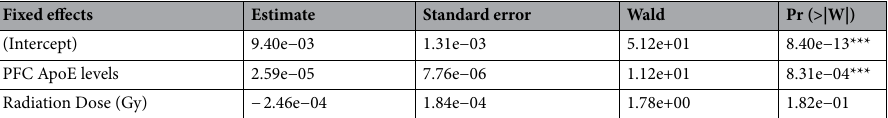
Table 5. Linear generalized estimating equations model results predicting relative amygdala volumes with ApoE in the PFC and radiation dose as independent predictors. *** p < 0.001; displayed p -values are uncorrected for multiple comparisons.